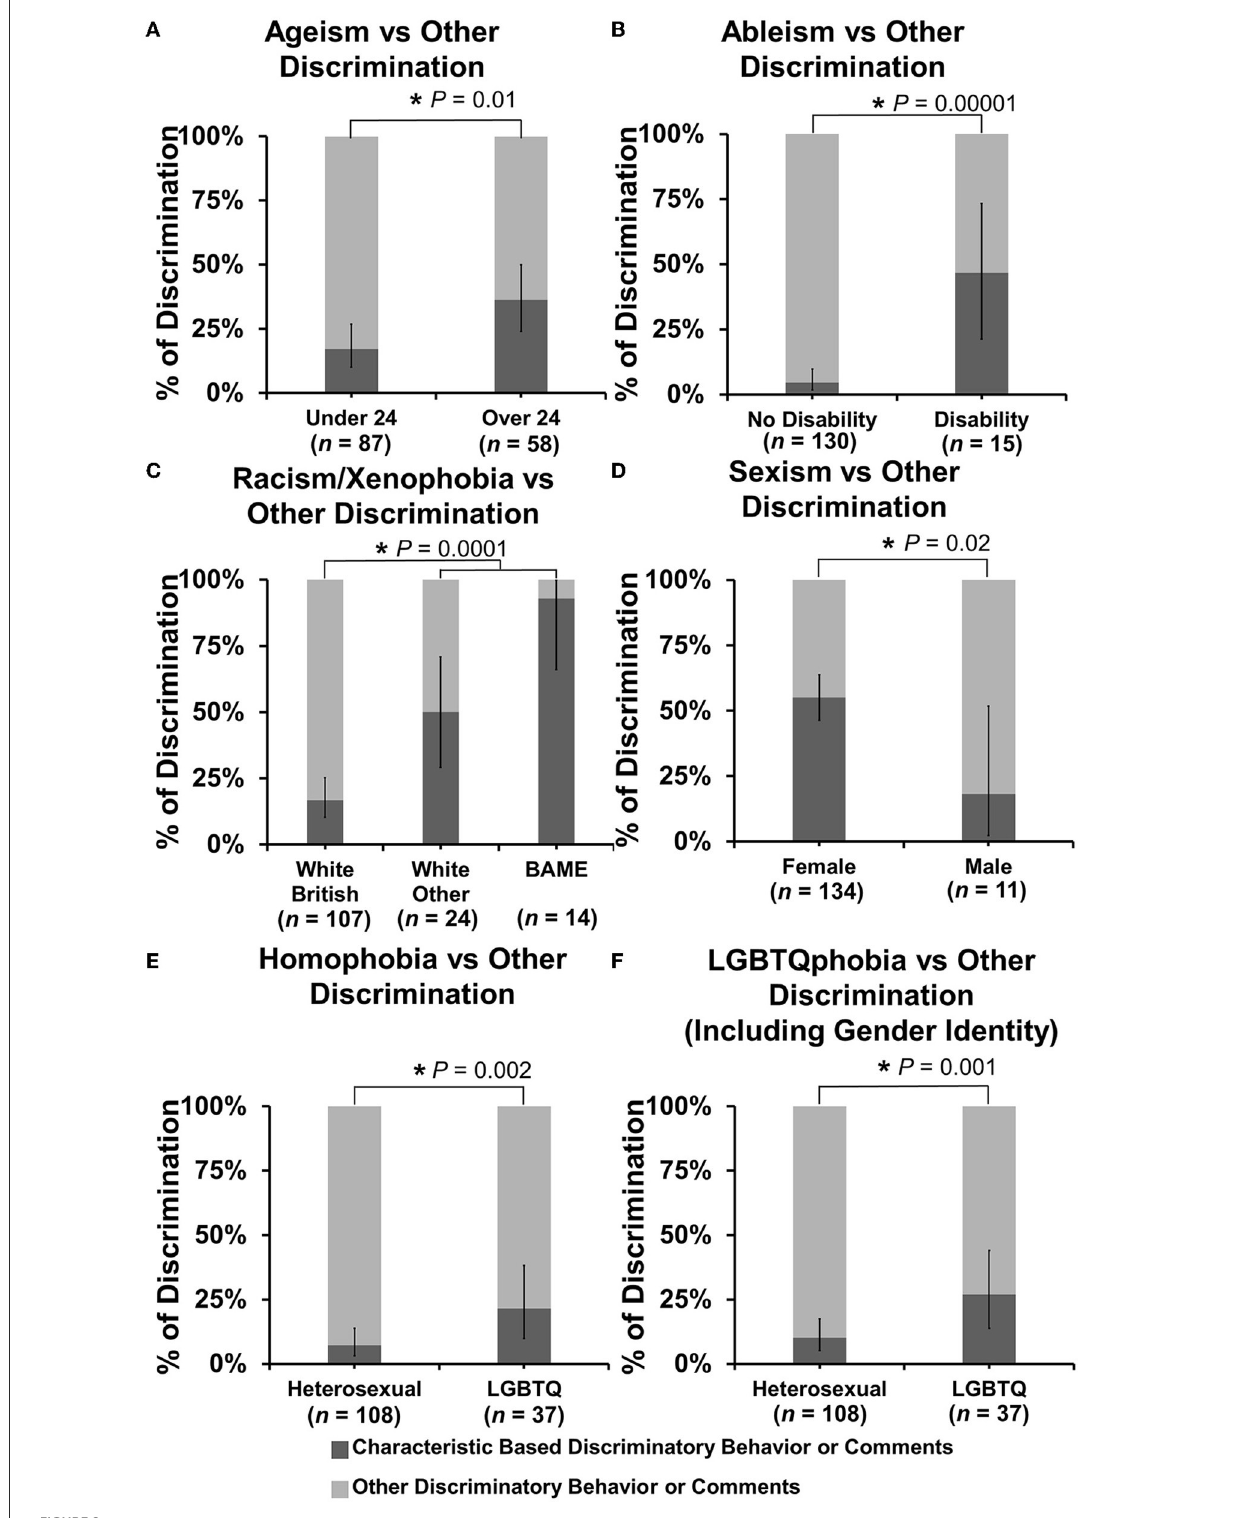
FIGURE2 Percentage of discriminating behavior or comments experienced or witnessed targeted toward specific characteristics. Discriminating behavior or comments were categorized based on age (ageism), disability status (ableism), ethnicity (racism/xenophobia), gender/sex (sexism), sexual orientation (homophobia), and LGBTQ status including orientation and gender identity (LGBTQphobia), and plotted as bar charts under relevant respondent demographic categories as percentages vs. any other type of discrimination experienced or witnessed. (A–F) Bar charts of percentage proportion of specific discrimination vs other discrimination by respondent demographic. Error bars represent 95% confidence intervals for proportion calculated by the Binomial “Exact” method. Statistical significance was determined by Pearson’s chi-squared test of the association of specific discrimination between respondent groups under each category. * P <